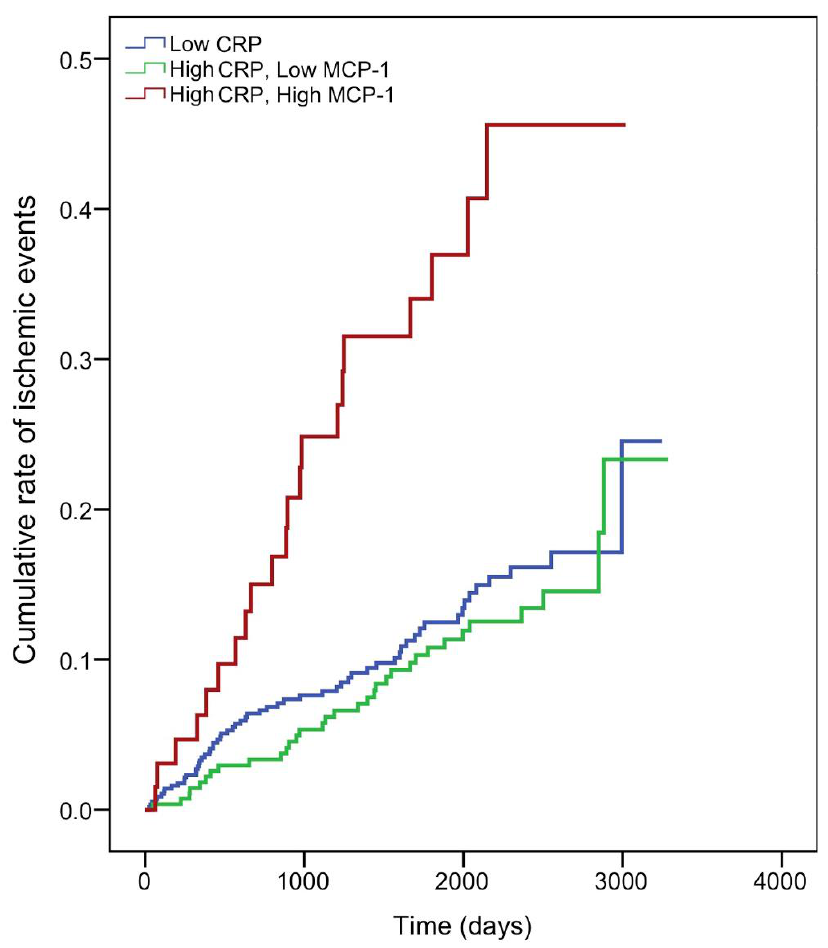
Figure 1. Kaplan–Meier plot of cumulative probability of an acute ischemic event when patients were grouped according to C-rective protein (CRP) and monocyte chemoattractant protein-1 (MCP-1) levels. CRP concentrations were defined as low (CRP < 2 mg/L) and high levels (CRP ≥ 2 mg/L). MCP-1 levels were defined as low MCP-1 ( ≤ 188 ng/L) or high MCP-1 (>188 ng/L), as determined by receiver operator characteristic curves.